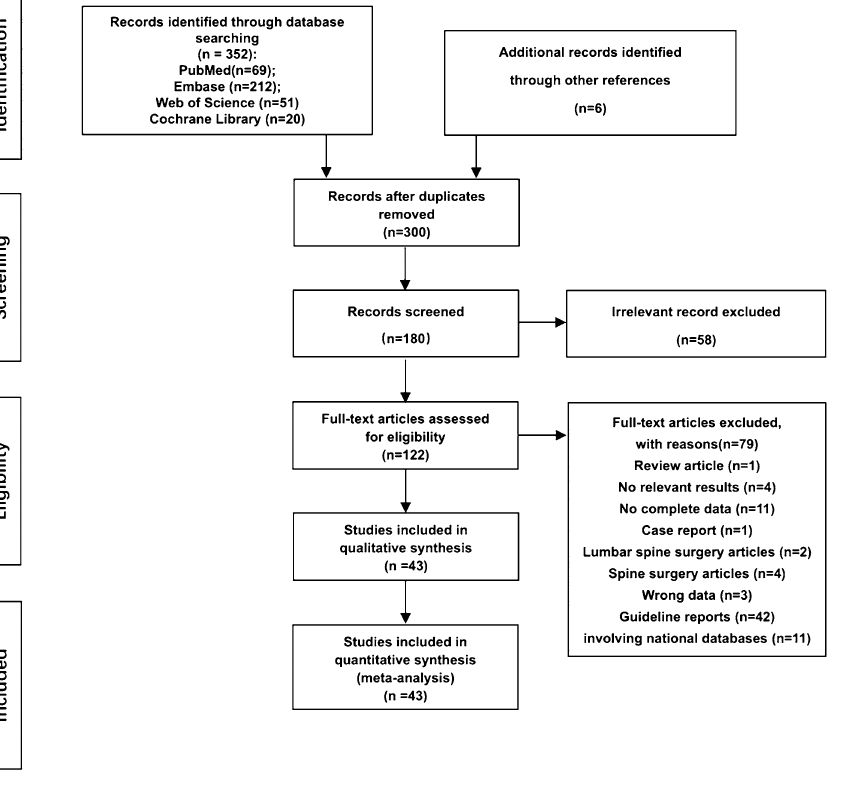
Figure 1. Flow diagram of study